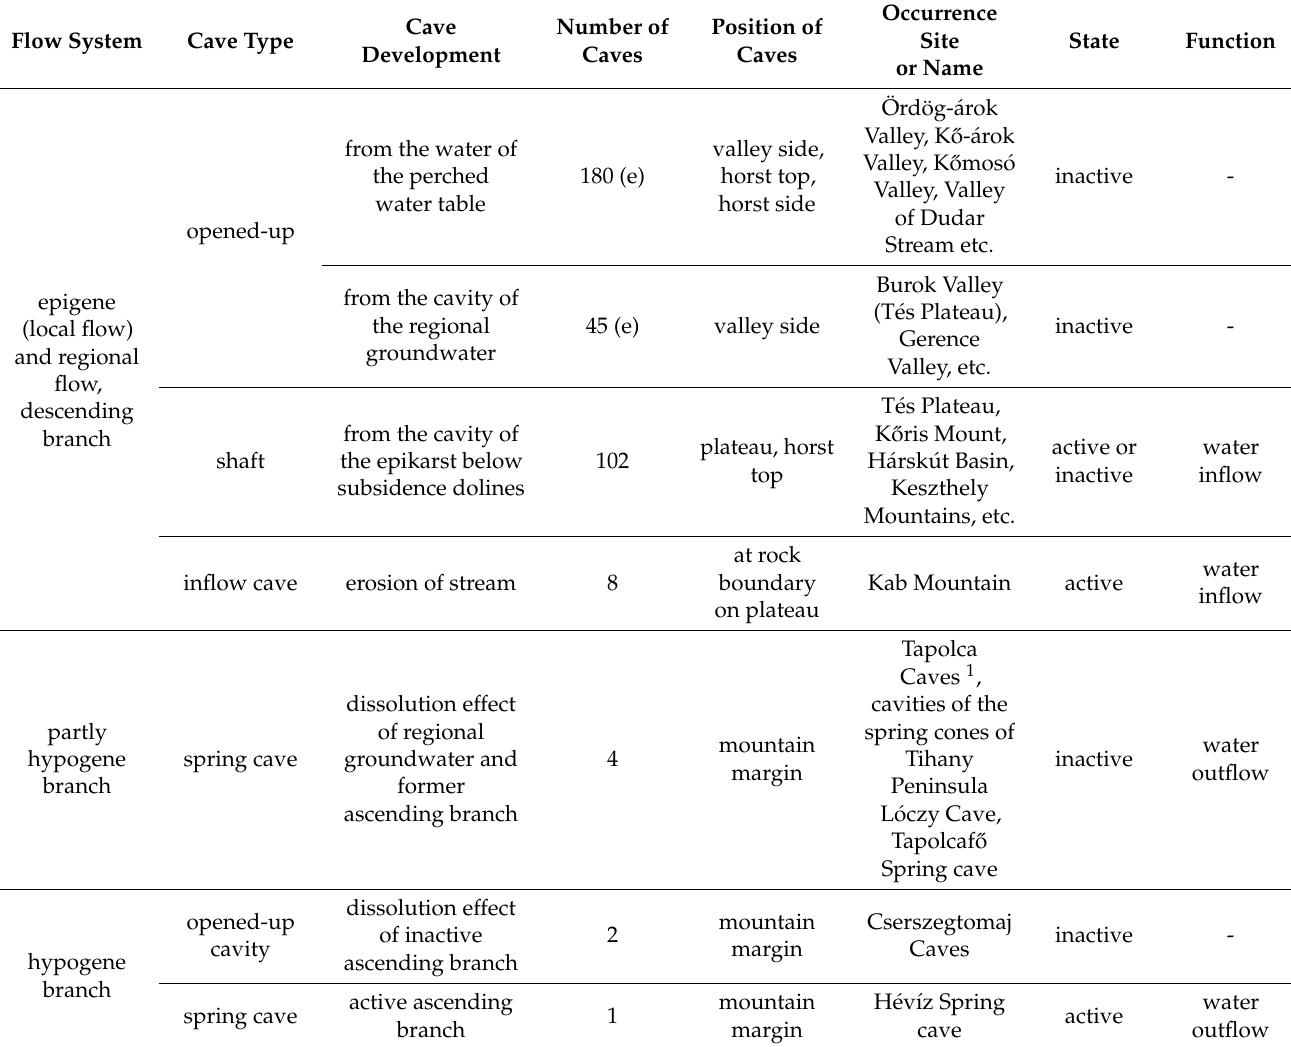
Table 1. The caves of the Bakony Region according to flow